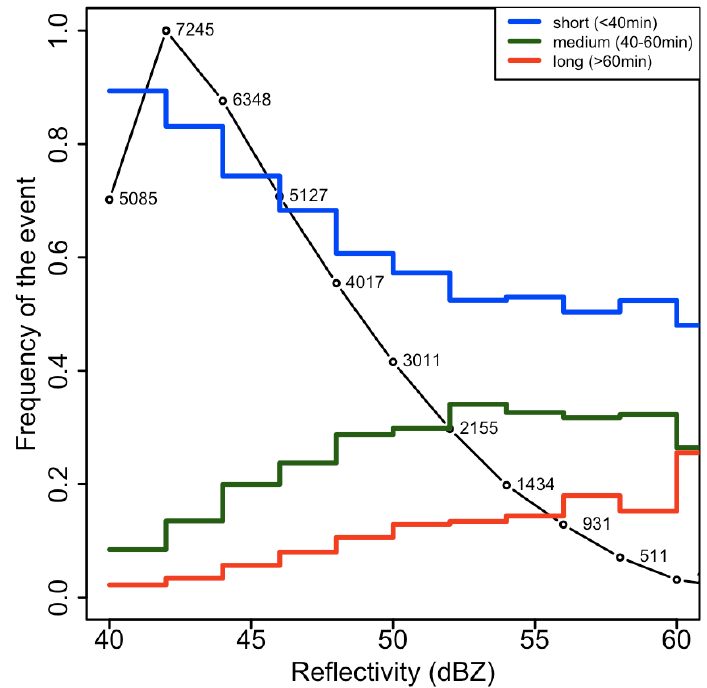
Figure 5. Number of events in function of the maximum of reflectivity recorded at the second instant (after 20 min) of the storm life cycle. The blue, green and red lines represent short, medium and long events, respectively. The black line represents the number of events within each class of reflectivity (2